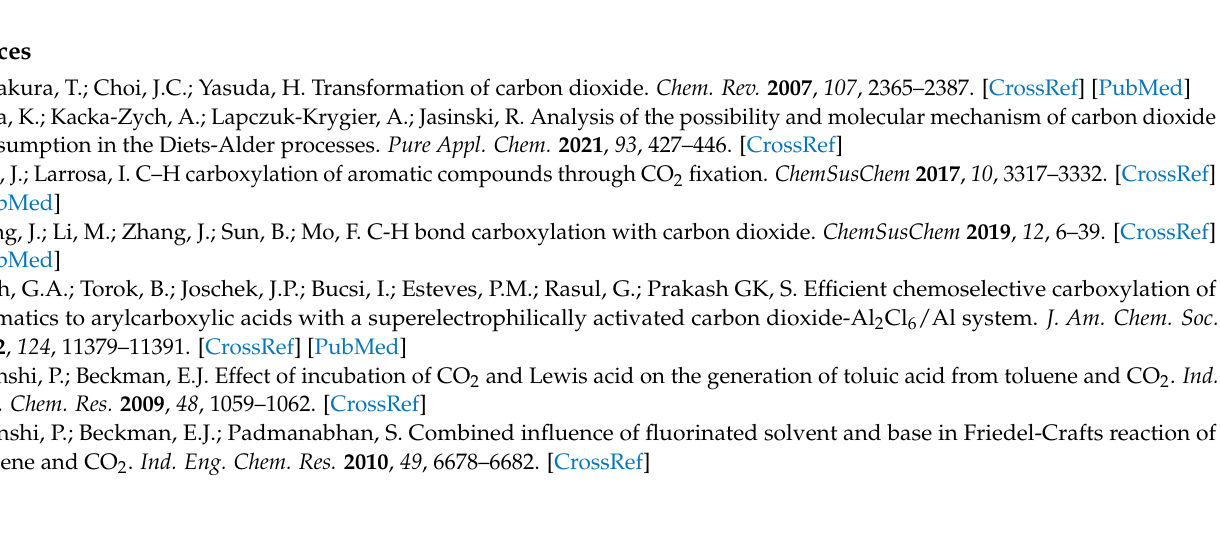
Figure S6: The TS geometry structure and the relevant interaction analyses including acetic acid for CO 2 insertion step: (a) Cu(OAc) 2 ; (b) Cu(OAc); (c) Ni(OAc) 2 ; (d) Rh(OAc) 2 . Figure S7: The TS geometry structure and the relevant interaction analyses excluding acetic acid for CO 2 insertion step: (a) Cu(OAc) 2 ; (b) Cu(OAc); (c) Ni(OAc) 2 ; (d) Rh(OAc) 2 . Figure S8: The interaction analysis for thiophene deprotonation step (CMD). Figure S9: The interaction analysis for the CO 2 insertion step